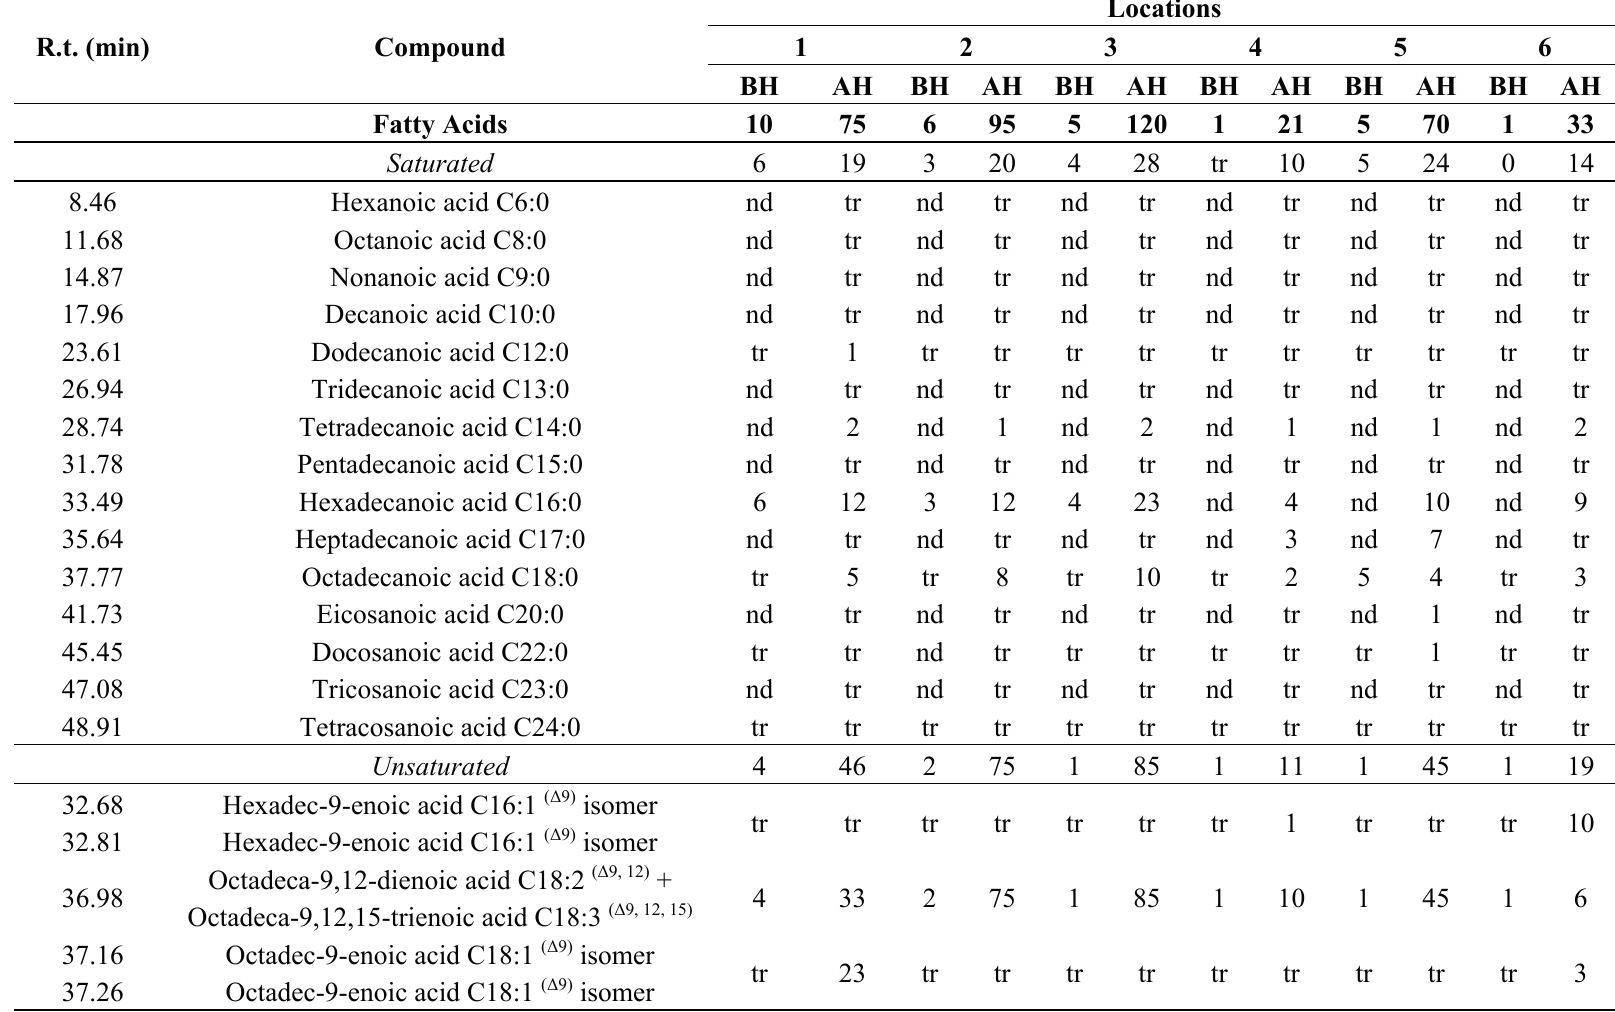
Table 2. Lipophilic composition (expressed as mg per 100 g − 1 fresh weight) of A. unedo berries collected from six locations in Penacova (center of Portugal) Portugal, before (BH) and after (AH) alkaline hydrolysis.